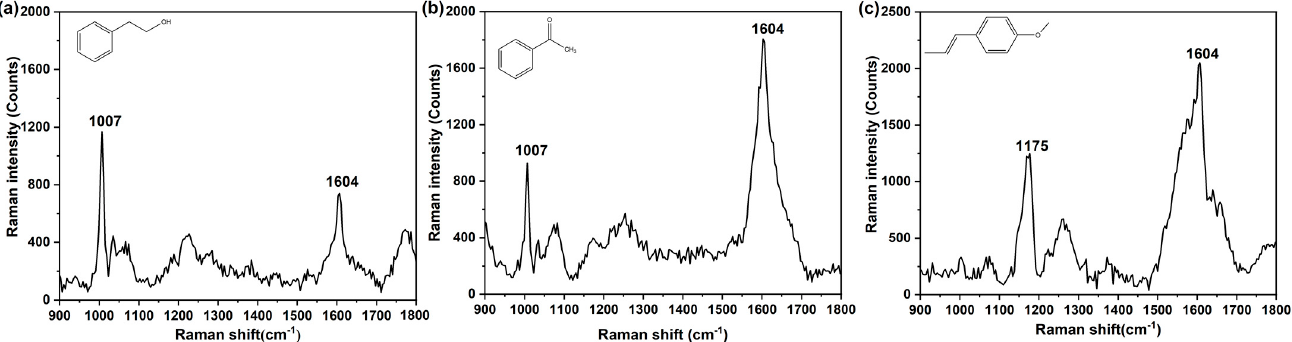
Figure 3. Raman spectra of ( a ) phenethyl alcohol gas, ( b ) acetophenone gas and ( c ) anethole gas.